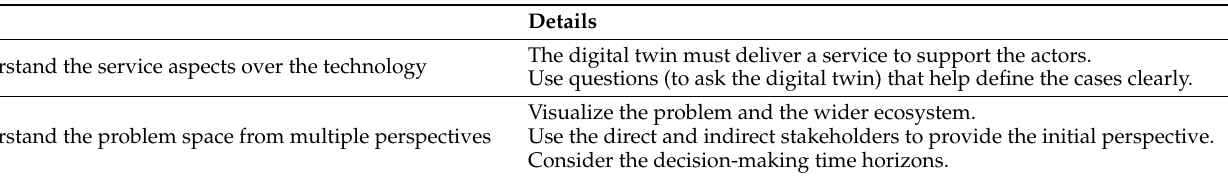
Table 5. Managerial issues to consider when designing solutions based on digital